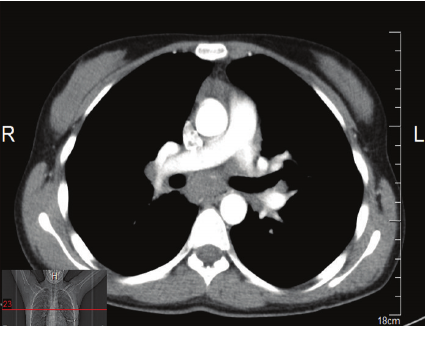
Figure 5: Thoracic CT